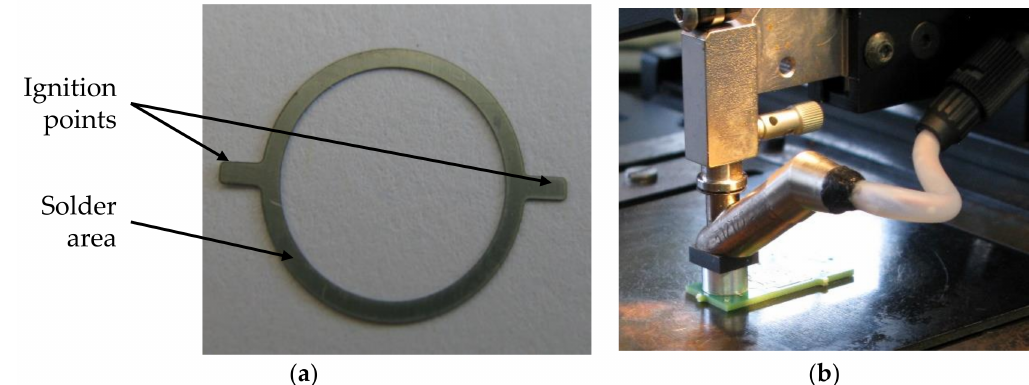
Figure 8. Reactive joining: ( a ) RF preform; ( b ) flip chip bonder with heated placement head used for reactive joining in this